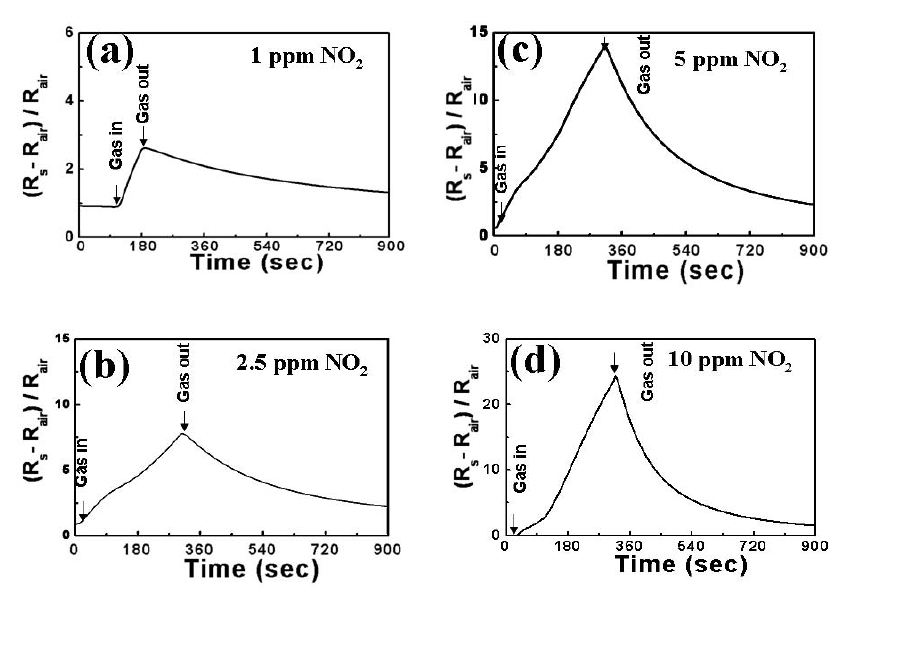
Figure 4. Dynamic responses of ZnGa NO concentrations of (a) 1 ppm, (b) 2.5 ppm, (c) 5 ppm, and (d) 10 ppm in synthetic air at 2 250 °C,